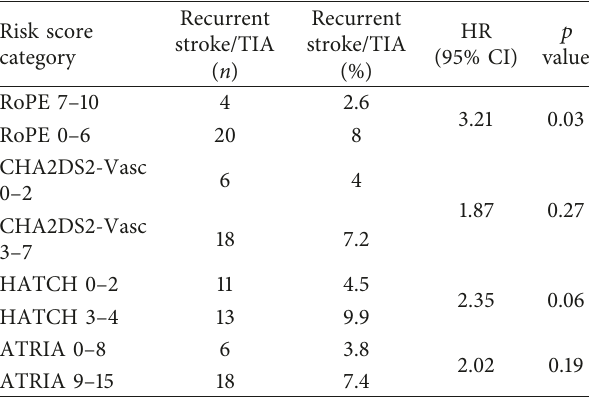
Figure 2: Kaplan–Meier plot showing freedom from stroke or TIA over a 10-year time frame. Table 3: Subgroup analysis of incidence of recurrent ischemic neurological